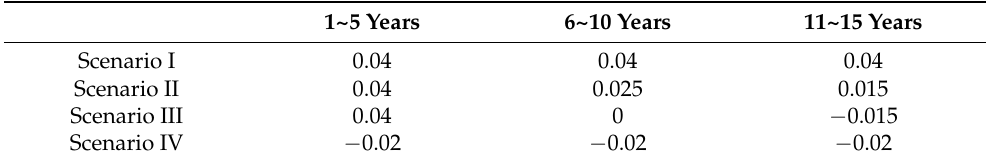
Table 3. Assumption of the annual growth rate of initial reference demand at different stages in the planning period in four scenarios (the reference demand for the first year is 23,500